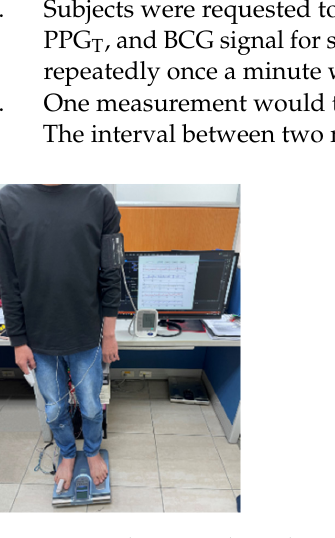
Figure 5. A subject stands on the commercial weight scale. The finger of right hand and toe of right foot wears the PPG probes. The cuff of blood pressure monitor is wrapped on the left hand. Lead I ECG is measured.